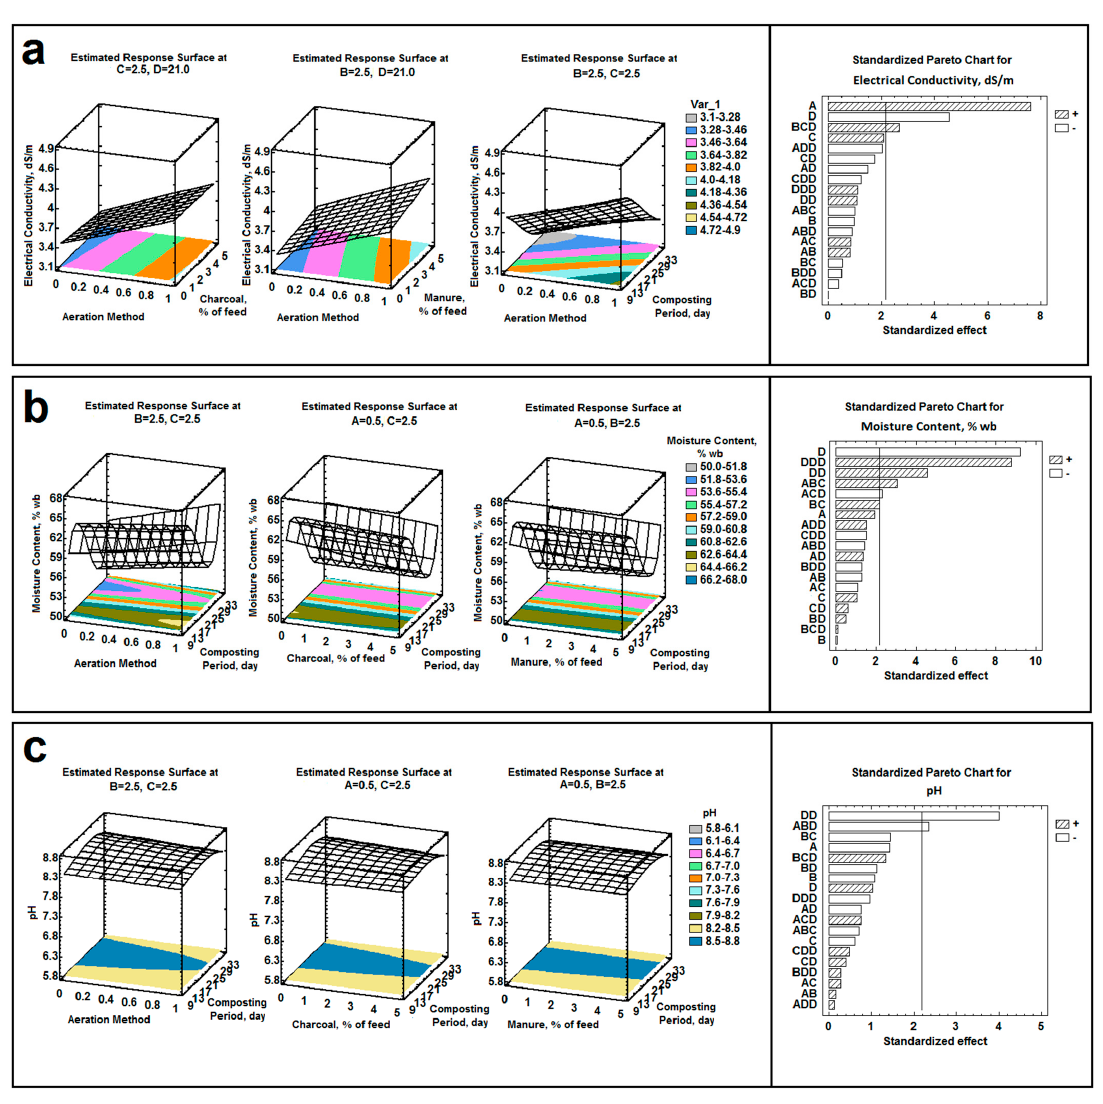
Figure 11. Estimated response surfaces and their contours below as a function of each two factors at a constant value of other factors with Pareto charts for each response of ( a ) electrical conductivity; ( b ) moisture content; and ( c ) pH. Table 6. Response model constants of accumulative C/N reduction percentage, difference between maximum and ambient temperature and temperature uniformity